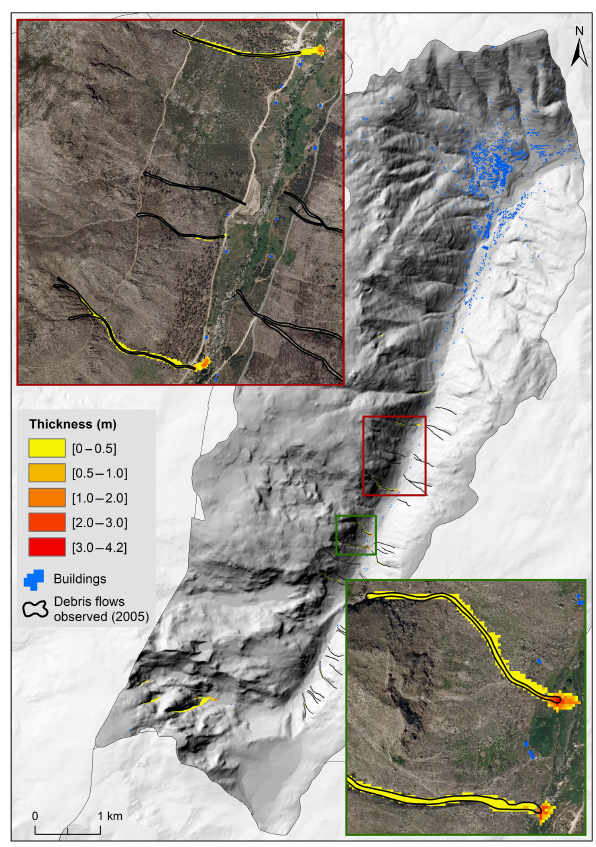
Figure 10. Debris flow run-out modeling on the basin scale, con- sidering excess rain of 30mmh − 1 (Scenario A).